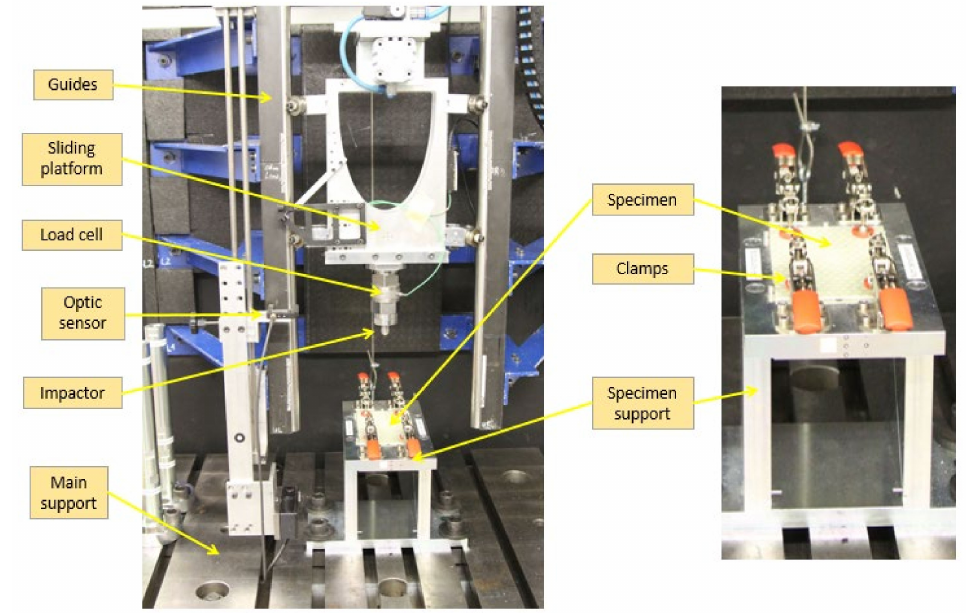
Figure 3. Setup for impact tests using the 15 m height impact test machine.